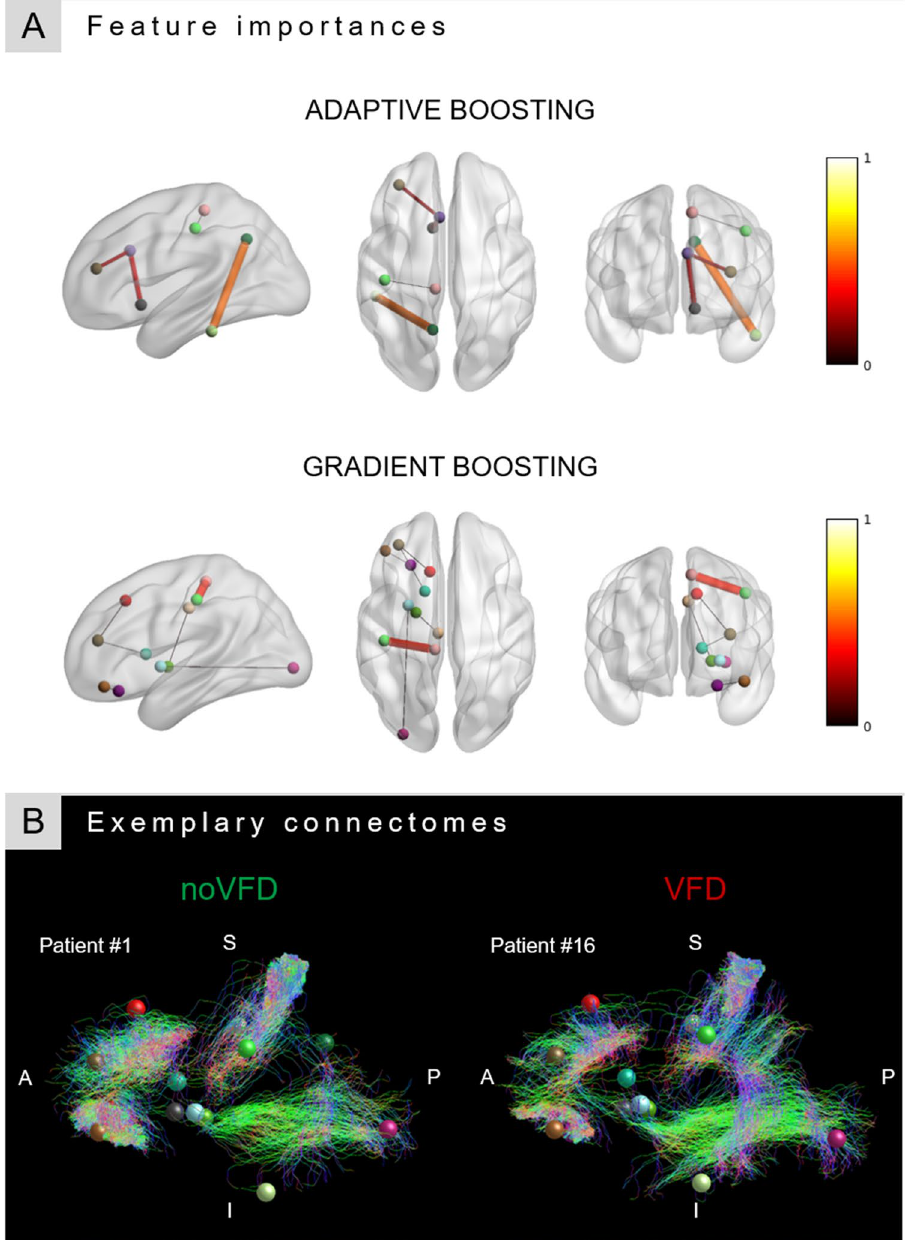
Figure 5. Features included in the ANN meta-classifier. ( A ) Specific post-hoc feature importances of the two boosting classifiers are visualized within the connectome. Both colour value and edge width indicate the respective Gini importance. ( B ) Exemplary streamline connectomes of the edges used by the ANN meta- classifier of a patient without (patient #1) and a patient with (patient #16) postsurgical VFD. Connectomes were downsampled to a total of 5000 streamlines for visualization purposes